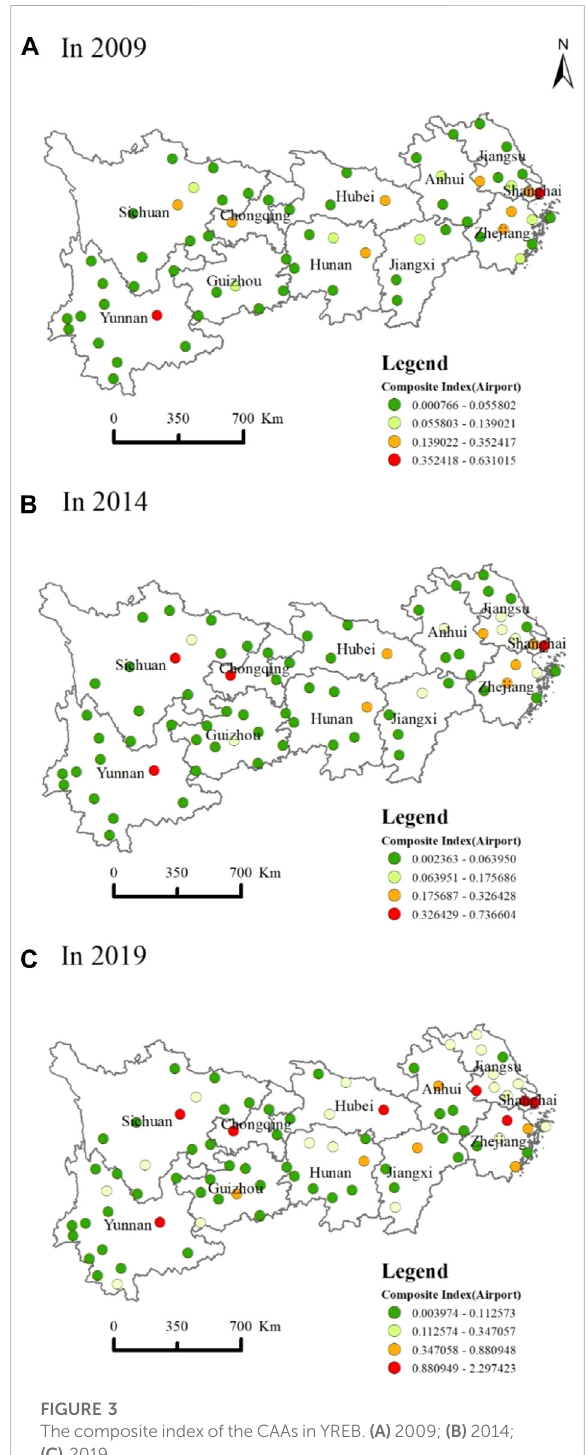
FIGURE 2 Provincial-level comprehensive index of CAAs in YREB: (A) 2009; (B) 2014; (C) 2019.